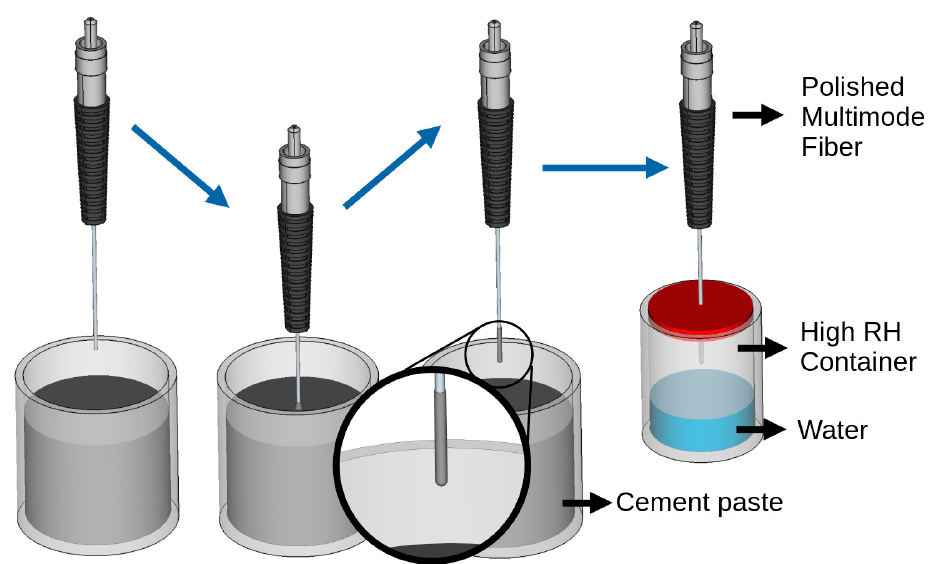
Figure 1. Cement paste sample production by dipping the fiber in cement paste and leaving it to cure in a closed container with water for a 7-day moist cure.